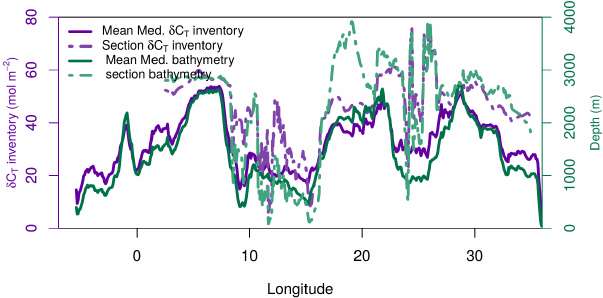
Figure 10. δC T inventory (molCm − 2 ) along the Meteor M51/2 section (dashed lines) and given as the meridional mean (solid lines) for the MED simulation (purple) along with corresponding model bathymetry (green).